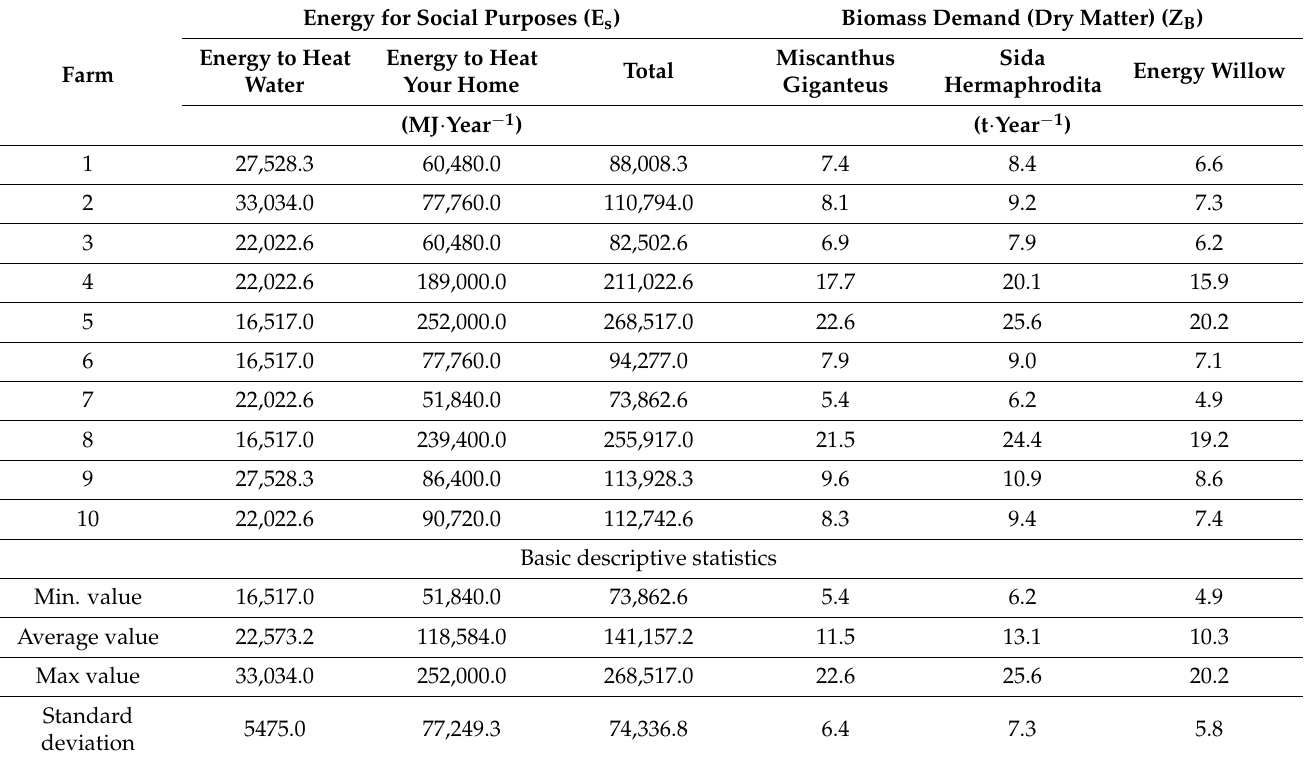
Table 5. The demand for energy (E s ) and biomass (Z B ) in the studied agricultural